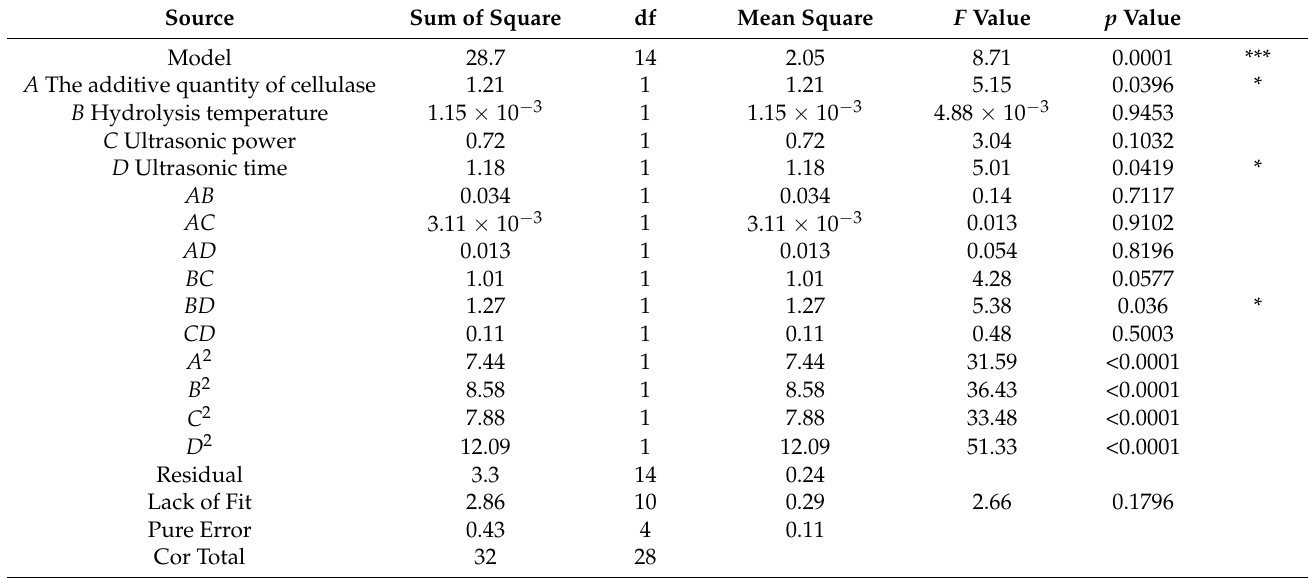
Table 4. Analysis of variance for the Box–Behnken regression